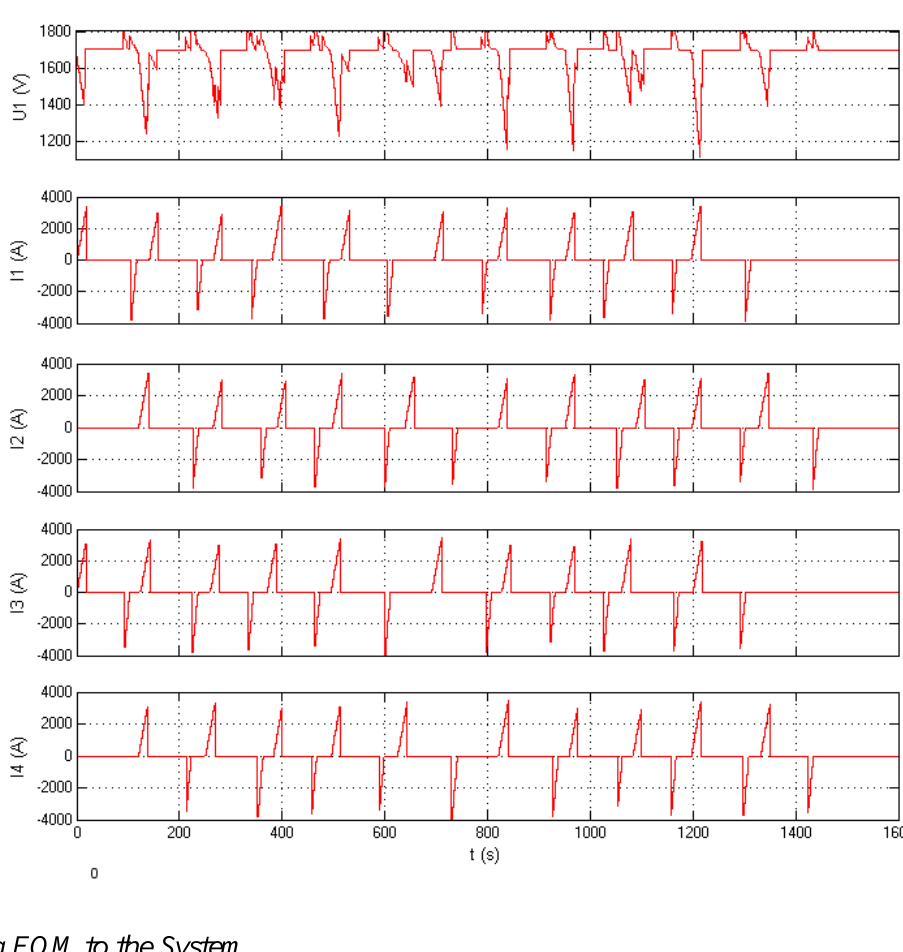
Figure 11. The voltage and current in simulation.